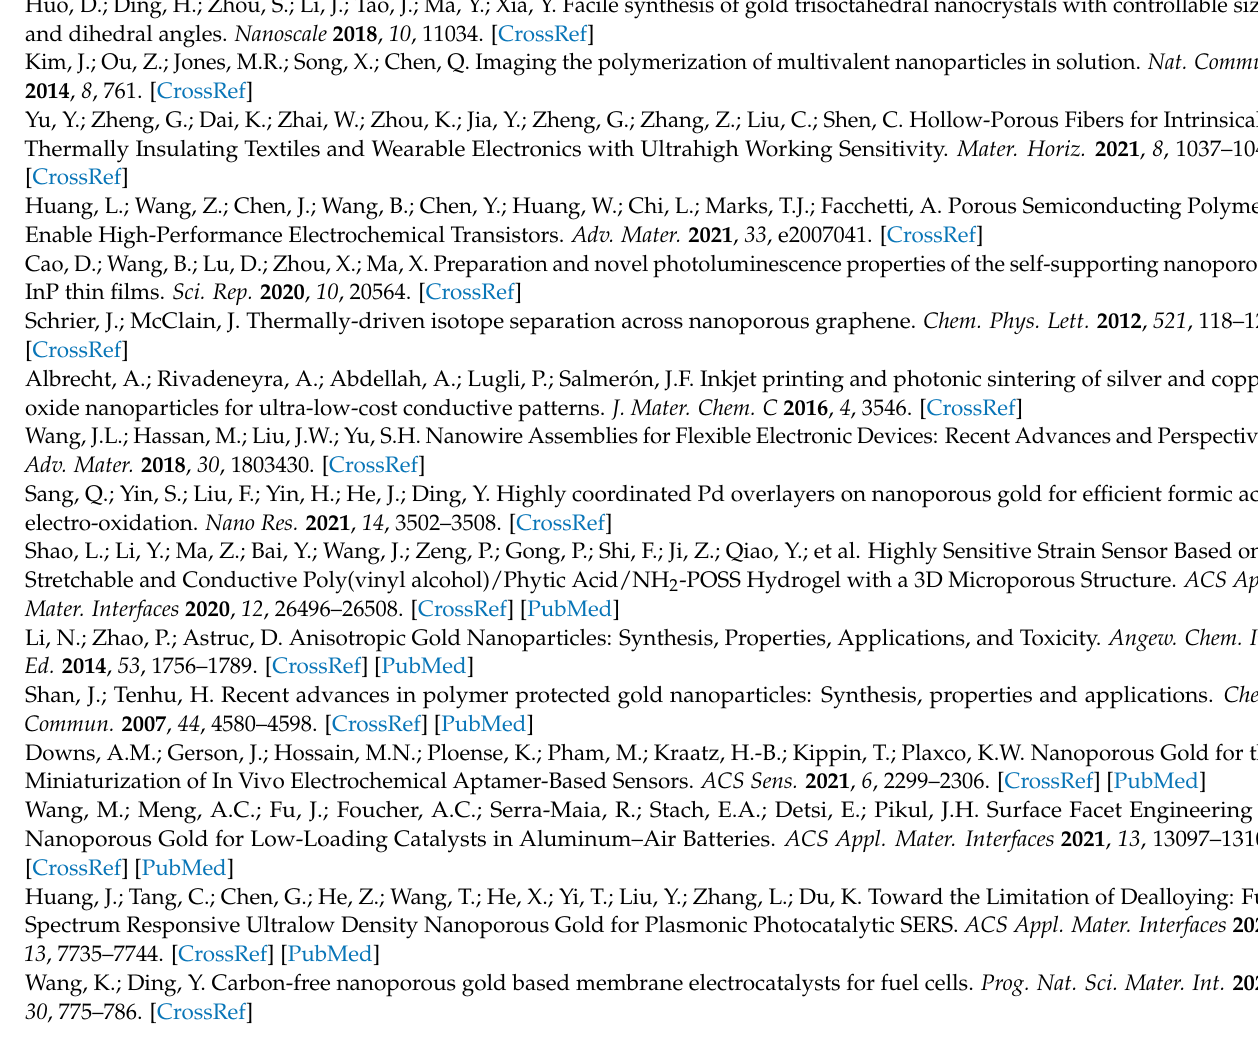
UV illumination; Figure S4: The corresponding I-t curves of the Au/ZnONWs photodetector. (a) The enlarged rise process of the current response under UV illumination, (b) The enlarged recovery process of the current response under UV illumination; Figure S5: The schematic diagram of the bending